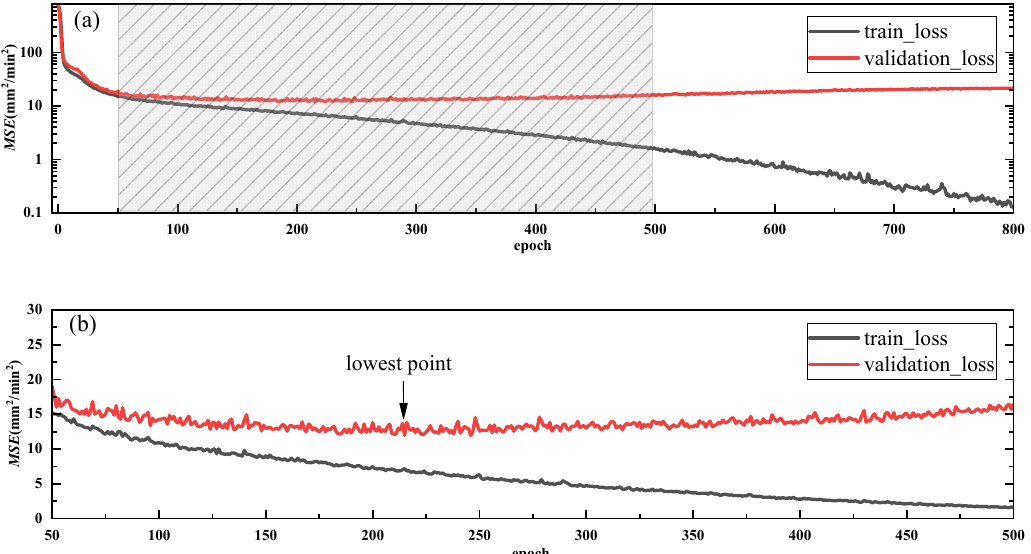
Figure 8. BPNN model training process of Strategy A. ( a ) the MSE values in total process. ( b ) the MSE values in 50–500 epochs.